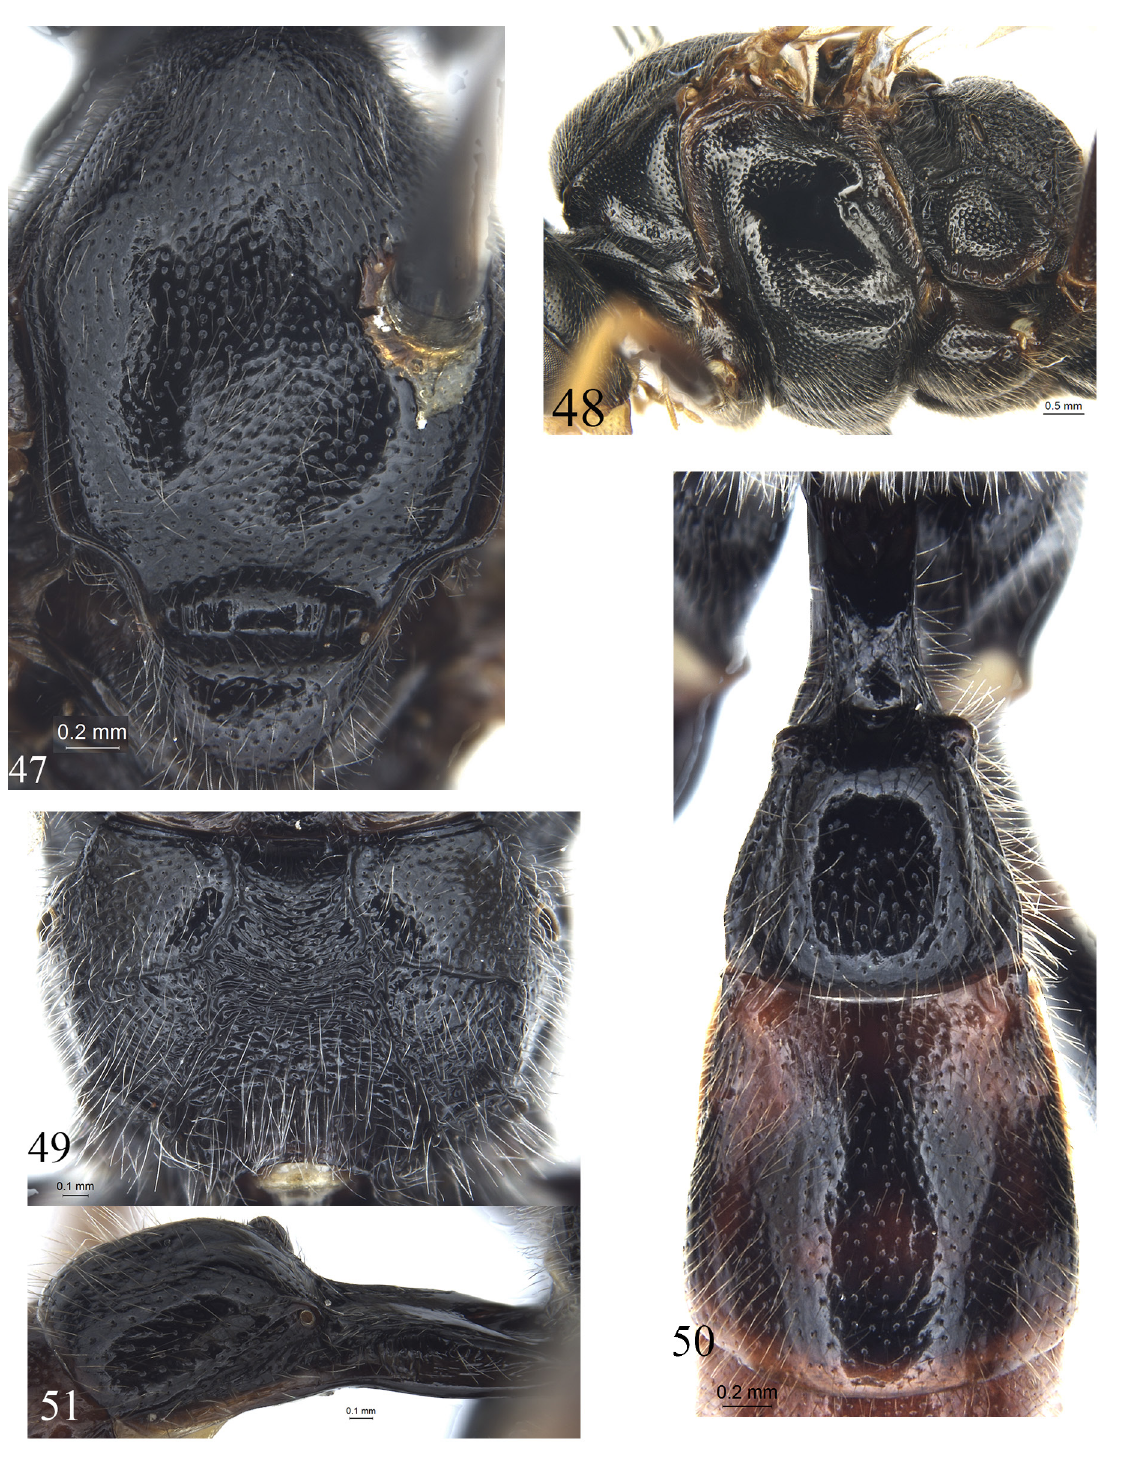
Figs 47–51. Ctenopelma spiraculare Sheng, Sun & Li sp. nov., holotype, ♀ (GSFGPM). 47 . Mesoscutum and scutellum. 48 . Mesosoma, lateral view. 49 . Propodeum. 50 . Tergites 1–2, dorsal view. 51 . First tergite, lateral